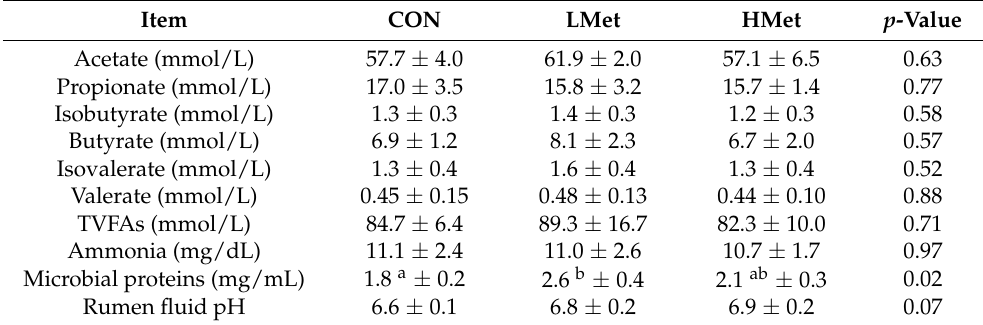
Table 6. Effect of methionine supplementation on rumen fermentation.